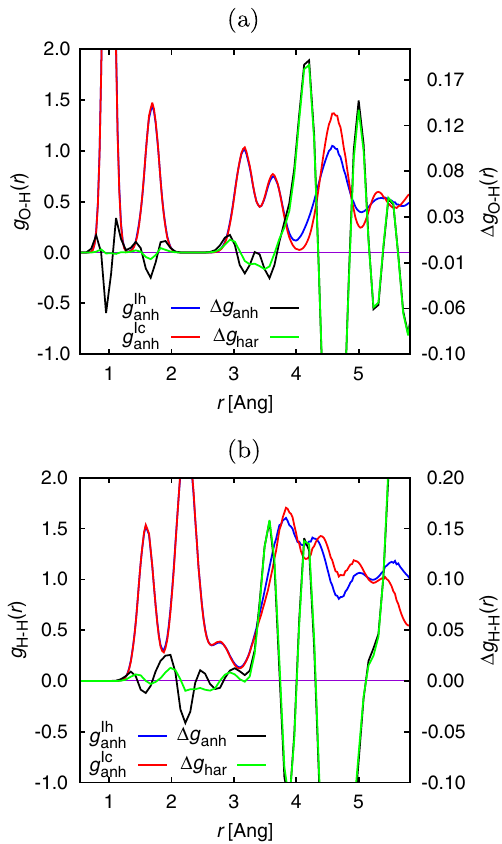
FIG. 10. The (arbitrarily picked) central proton is labeled 0th. FIG. 9. The O-H RDFs, g , (a) and H-H RDFs, g , (b) The nearest- to fourth-nearest-neighbors are labeled 1st through O-H ð r Þ H-H ð r Þ for Ih P 6 3 cm (blue lines) and Ic P 4 3 (red lines) are sampled from 4th. From the point of view of the central proton, the fourth- the anharmonic nuclear wave functions. For radii < 3 Å the nearest-neighbor protons first lead to a distinction between chair- difference between Ih and Ic at the harmonic level (green lines) and boat-form hexamers. The fourth-nearest-neighbor protons are Δ g ≡ g Ih − g Ic is very small. The difference at the anhar- found at distances from the central proton ranging from around har har har ≡ g Ih − g Ic monic level (black lines) Δ g is small, but non- 3.5 to 5.0 Å. The green and blue planes are spanned by the anh anh anh relevant O-O axes connecting the fourth-nearest-neighbor pro- negligible. The features in Δ g and Δ g for radii beyond har anh tons. (a) Typical chair-form configuration found in Ih and Ic. around 3 Å originate predominantly from differences in the static (b) Typical boat-form configuration found only in structures of Ih and Ic.